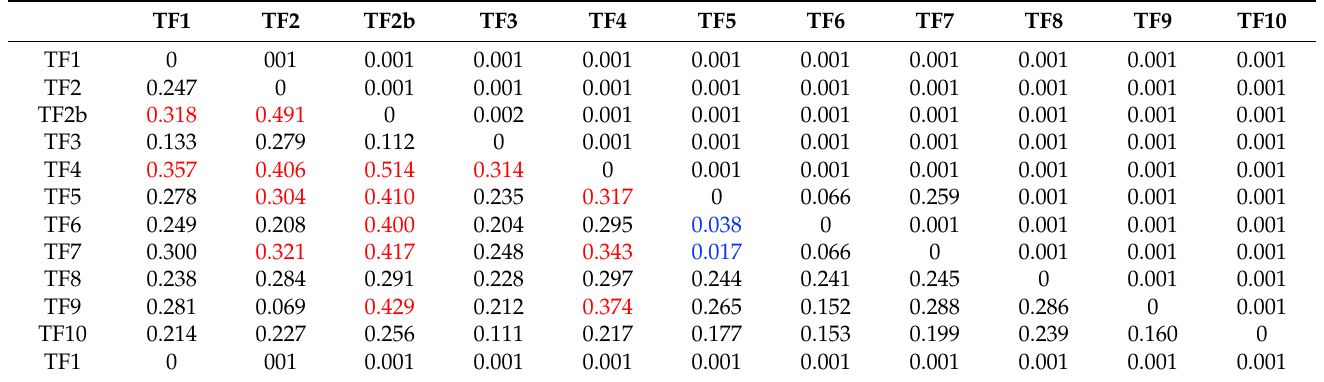
Table 1. Pairwise F ST values between the analyzed T. fragiferum populations.